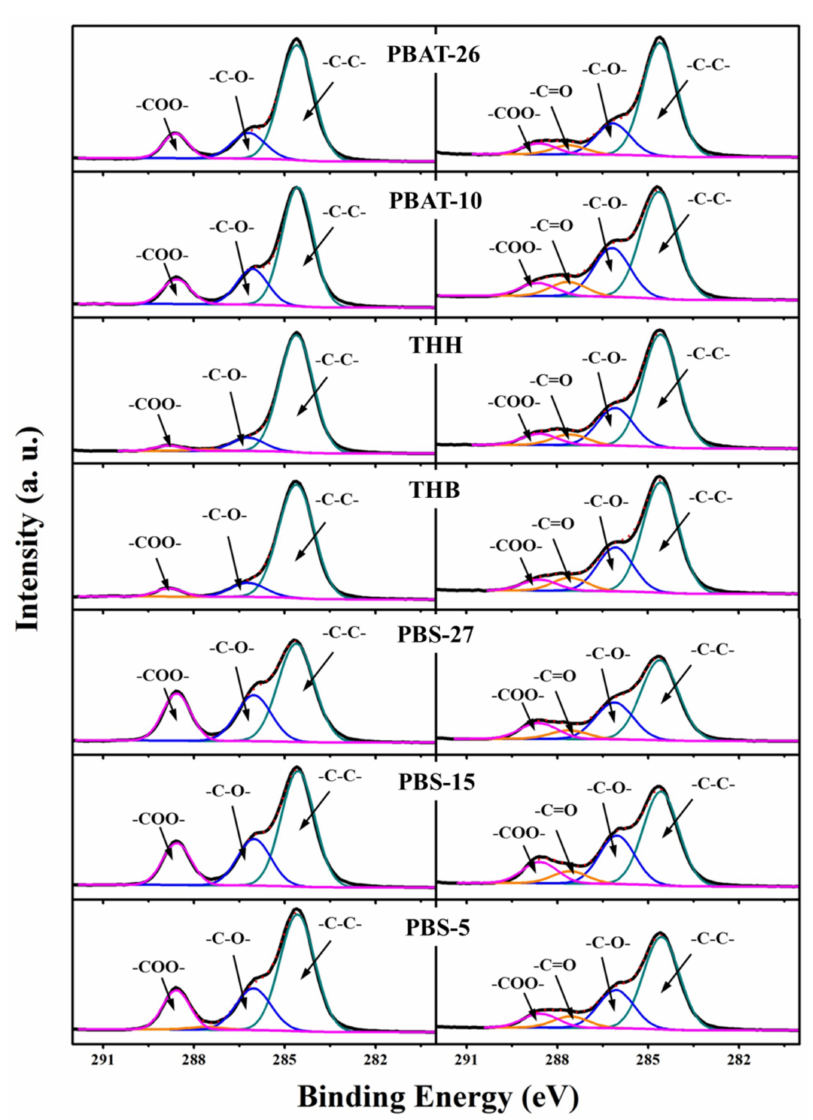
Figure 5. XPS C1s core–level spectra of PBAT and PBS mulching films before and after degradation for 75 days. Table 2. The weight average molecular weight ( M w ) and polydispersity (PDI) of PBAT and PBS